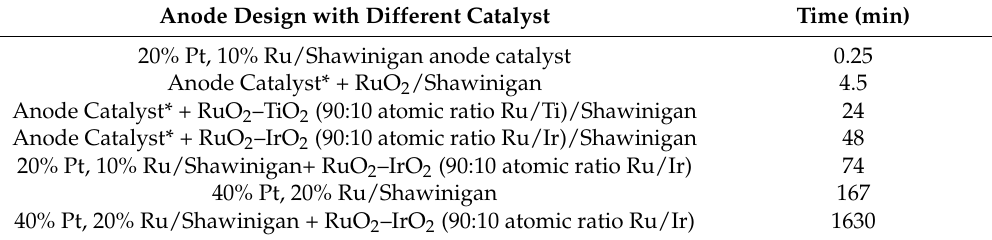
Table 3. The catalysts effect in anodes on the cell reversal tolerance in Step 3 of the protocol. Reproduced with permission from [16]. Copyright ECS, 2006. Anode Design with Different